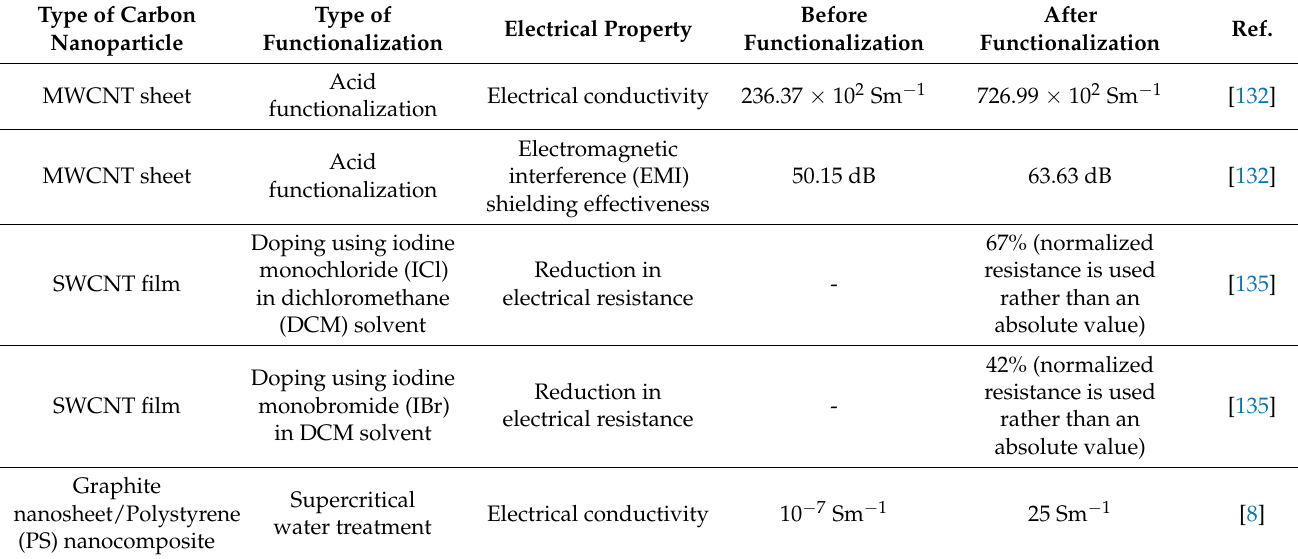
Table 7. Various electrical properties of carbon nanoparticles before and after